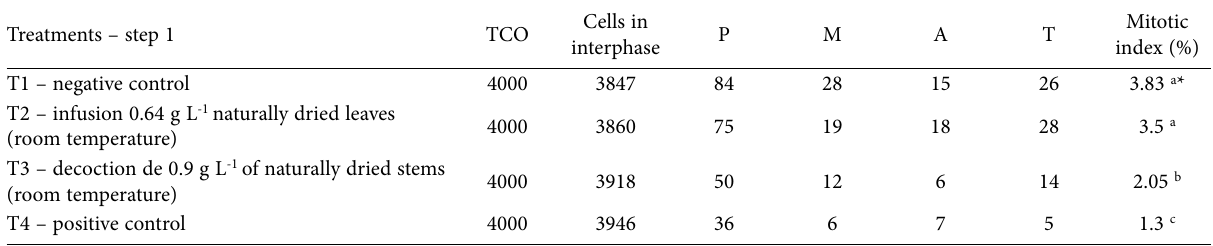
Table 2. Number of analyzed Allium cepa cells and mitotic indices (MI) of treatments of dried leaves and stems of Plectranthus barbatus at room temperature.